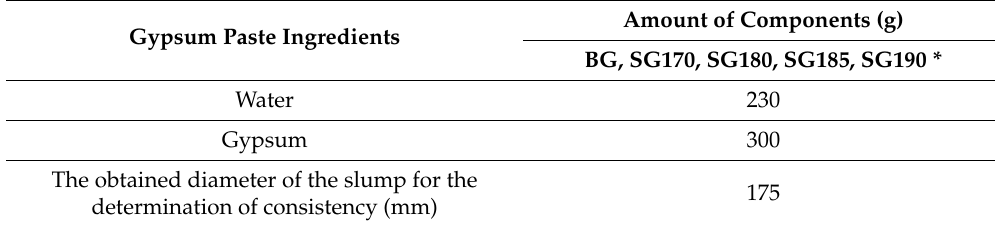
Table 4. List of the types of tested gypsum pastes.